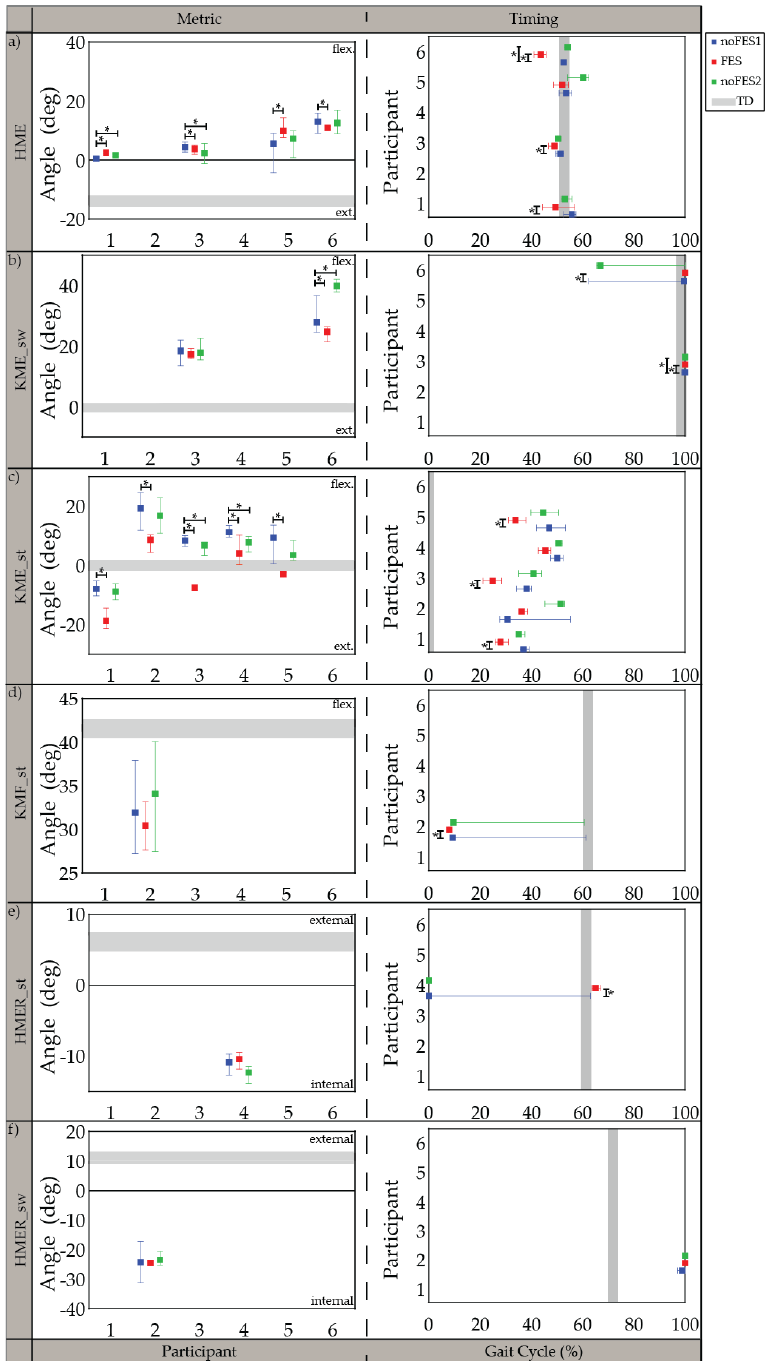
(red) , and noFES2 (green) walking conditions. ( a ) peak propulsive force ( AGRF ) and ( b ) minimum toe clearance in swing period ( TC_sw ). Gray band represents 95% CI for typically developing ref- erence dataset ( TD ). * indicates significance between walking conditions.